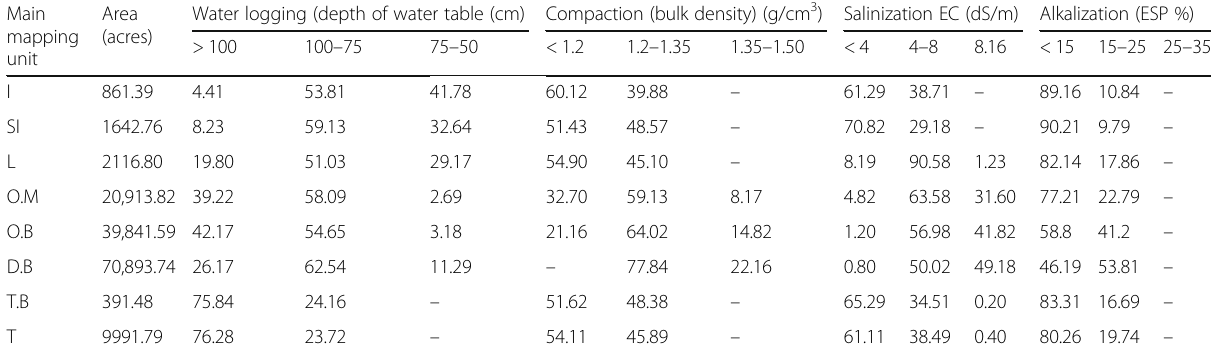
Table 11 Relative extent (%) of the land degradation types Main mapping unit